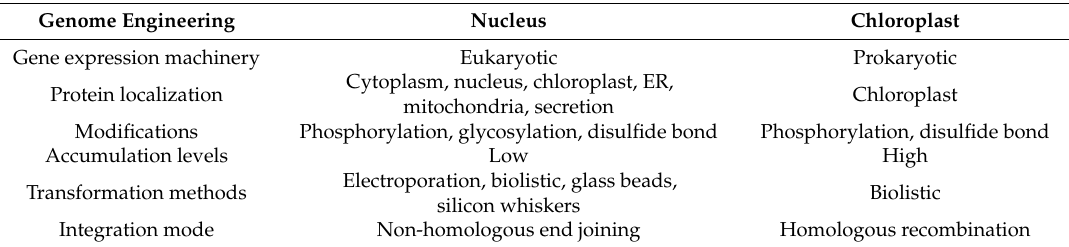
Table 2. Differences between the genome engineering of the nucleus and